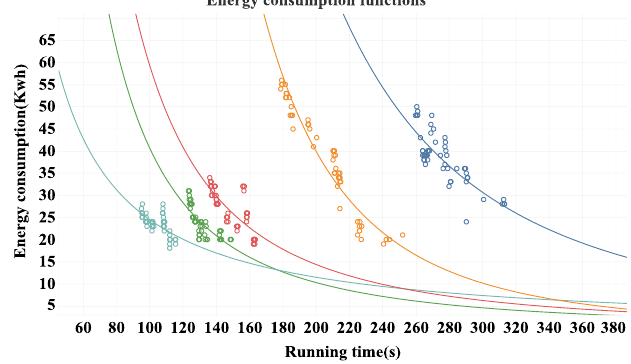
Figure 3. Energy consumption